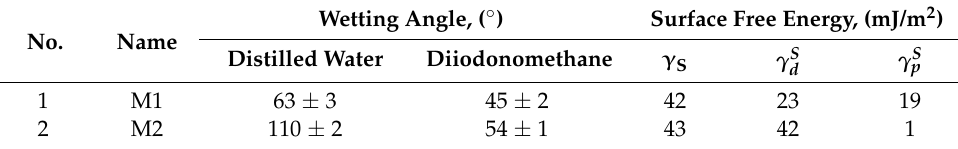
Table 6. Results of contact angle measurements and calculated